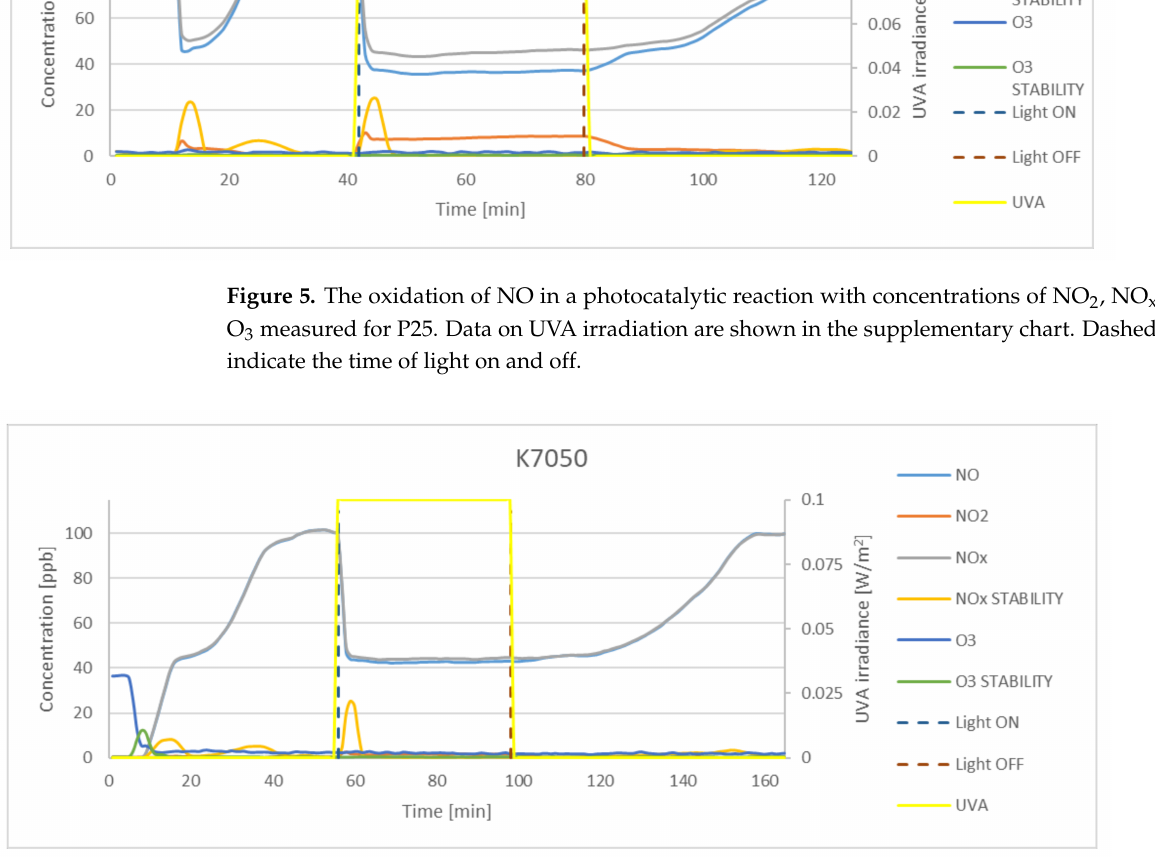
Figure 6. The oxidation of NO in the photocatalytic reaction with concentrations of NO 2 , NO x , and O 3 measured for K7050. Data on UVA irradiation are shown in the supplementary chart. Dashed lines indicate the time of light on and